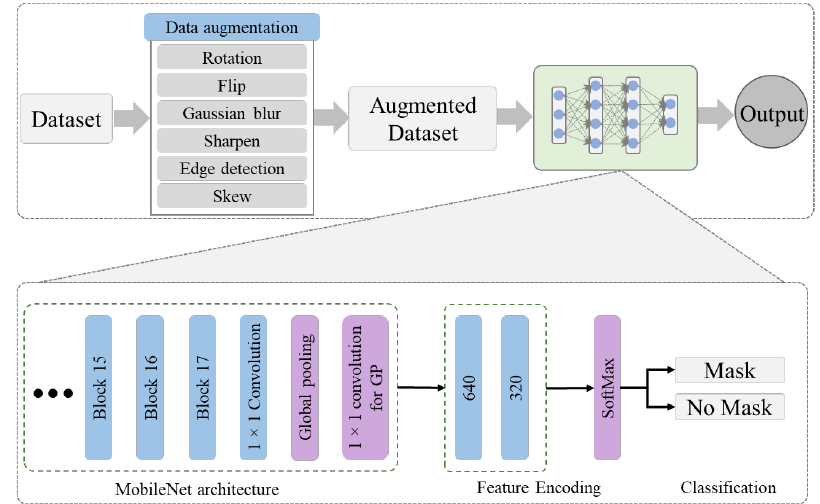
Figure 1. The visual representation of the proposed model.